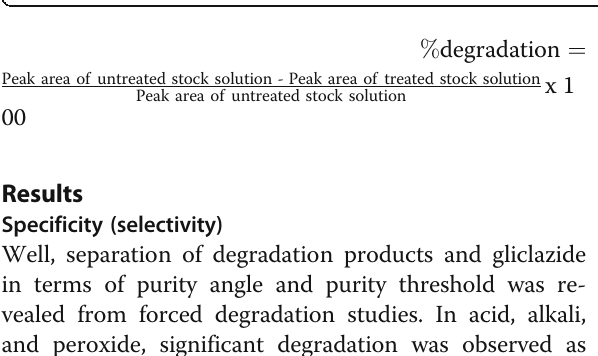
Fig. 3 Linearity of gliclazide. a Preparation of blank, b Preparation of standard